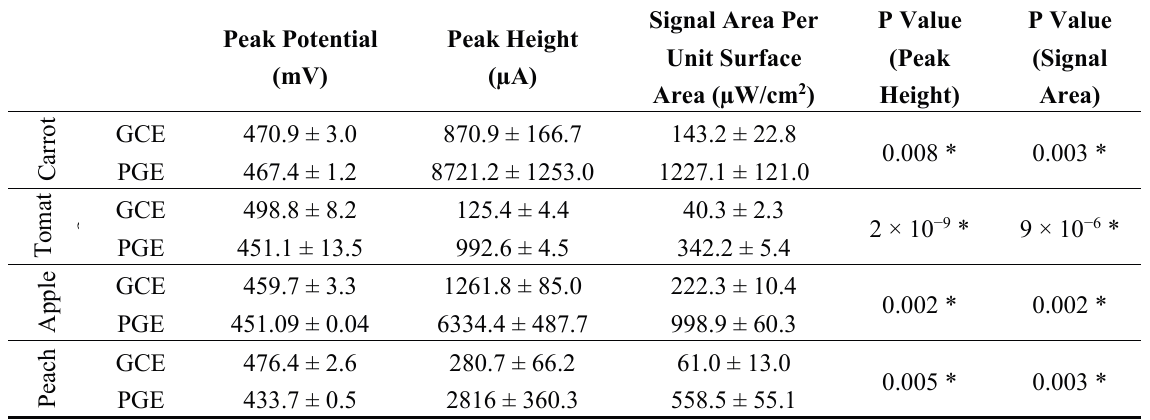
Table 3. Analysis of electrodes in fruit and vegetable